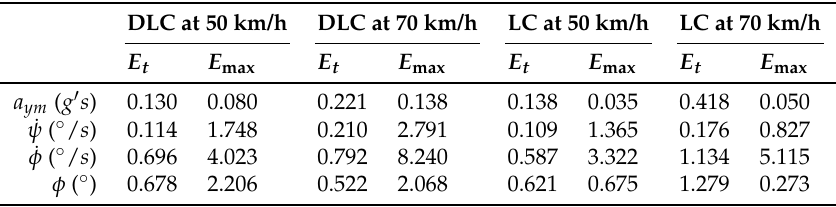
Table 2. Norm and maximum errors for the DLC and LC